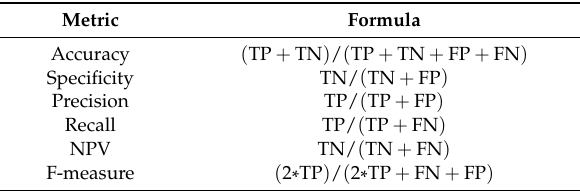
Table 3. Evaluation